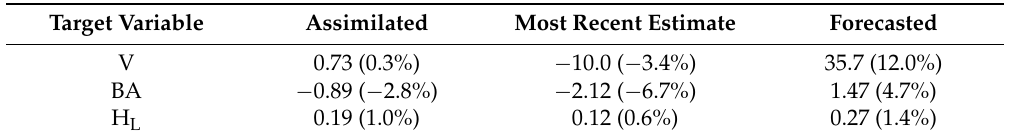
Table 5. Mean deviation ( MD ) from the field measurement 2011 for the nine assimilated plots. A positive MD means that the value is on average overestimated compared to the field measurements. In parentheses is relative MD .